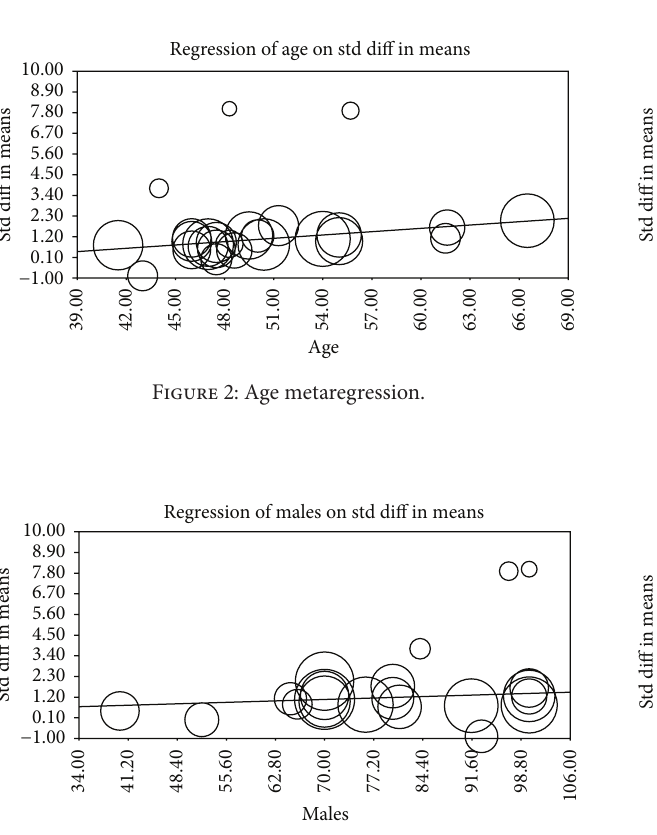
Figure 1: Meta-analysis.